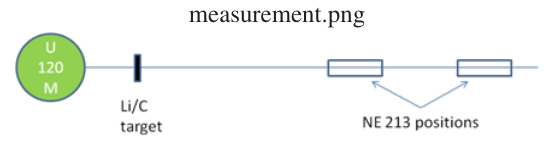
Figure 2. Principle of the TOF measurement